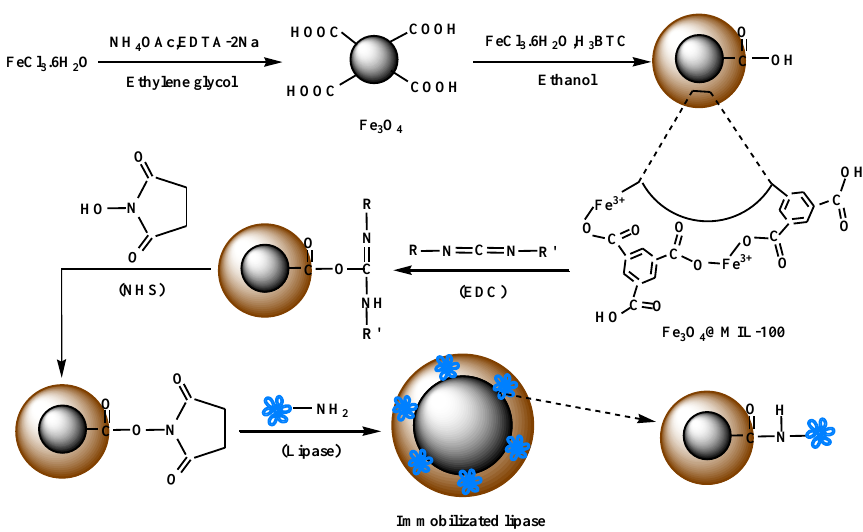
Figure 1. Schematic representation of the preparation of core-shell structured Fe 3 O 4 @MIL-100(Fe) composites and the subsequent immobilization of lipase onto the magnetic composite.